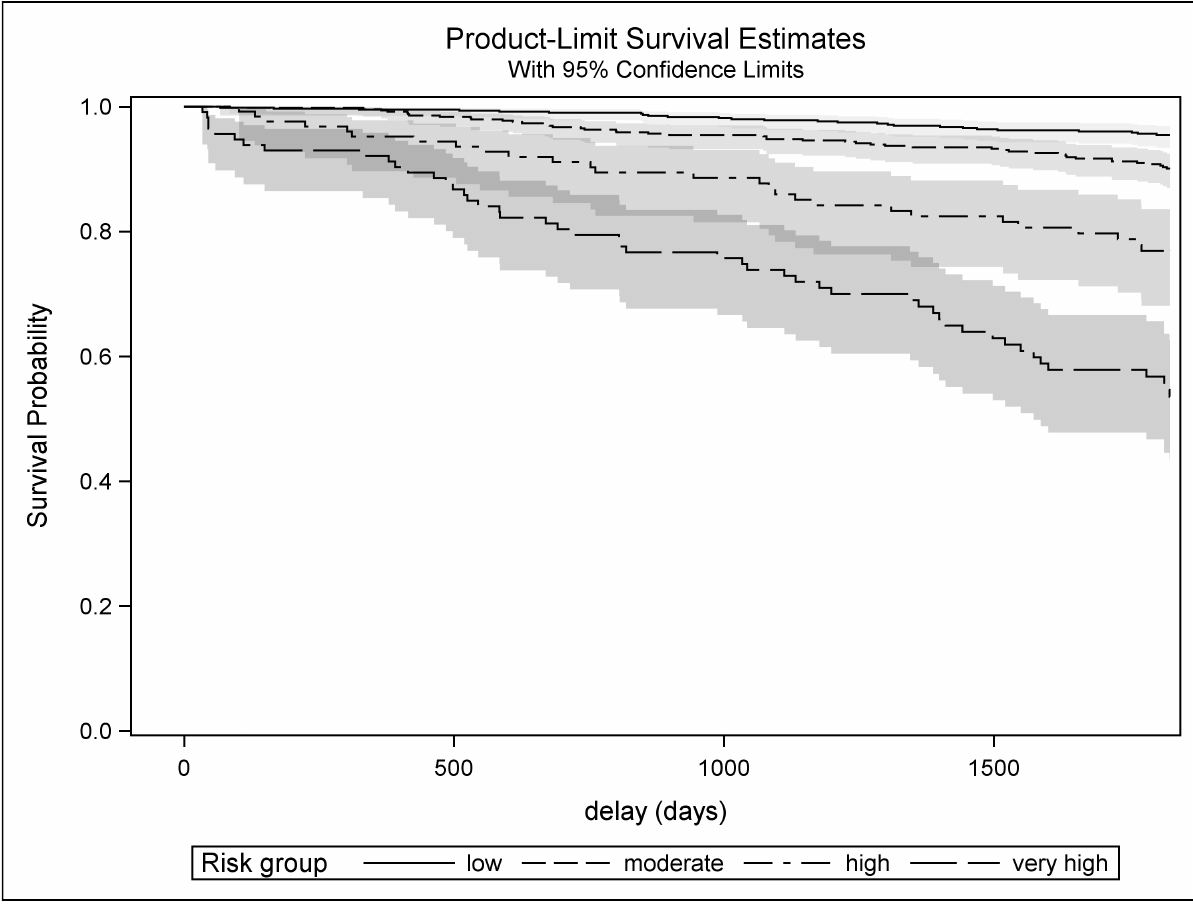
Fig 1. Five-year Kaplan-Meier survival probabilities among each risk group.